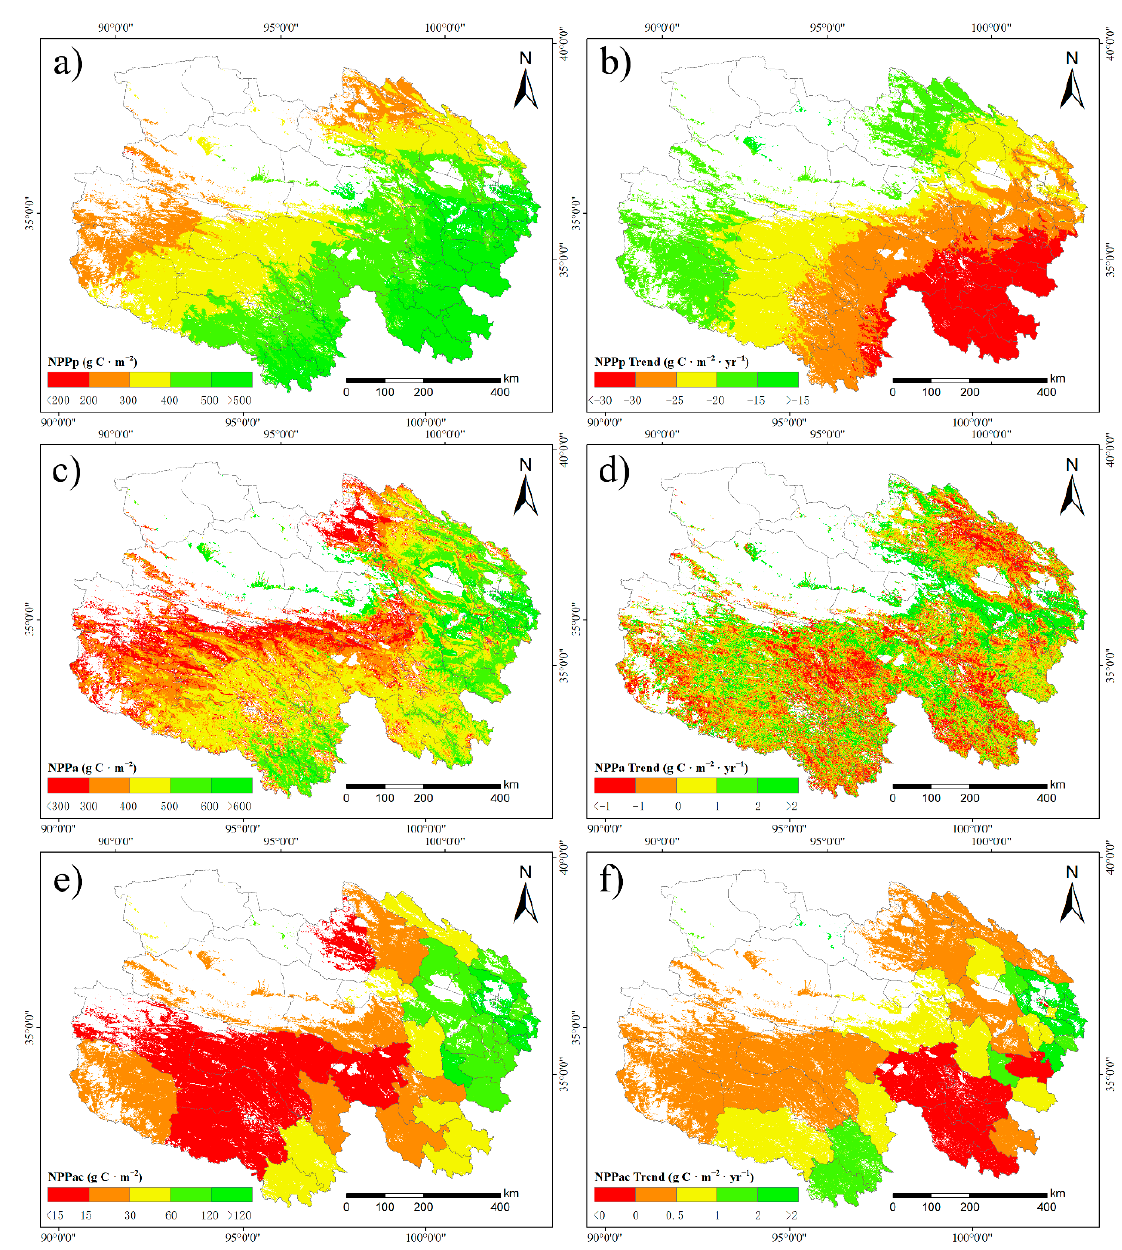
Figure 3. Spatiotemporal patterns of NPP p , NPP a , and NPP ac in alpine grassland in Qinghai Province from 2005 to 2018: ( a ) mean annual NPP p ; ( b ) change trend of NPP p ; ( c ) mean annual NPP a ; ( d ) change trend of NPP a ; ( e ) mean annual NPP ac ; ( f ) change trend of NPP ac . The simulated results (NPP p and NPP a ) were verified based on the measured data (Figure 4). Based on the obtained results, there existed an obvious positive association between the measured NPP data and the simulated NPP data. The R 2 between the measured NPP and the NPP p was 0.60 ( p < 0.001), the RMSE reached 101.73 gC · m − 2 · yr − 1 , with the MAE being 82.86. Additionally, the R 2 between the measured NPP and the NPP a reached 0.71 ( p < 0.001) and the RMSE was 61.38 gC · m − 2 · yr − 1 , with the MAE being 50.66.